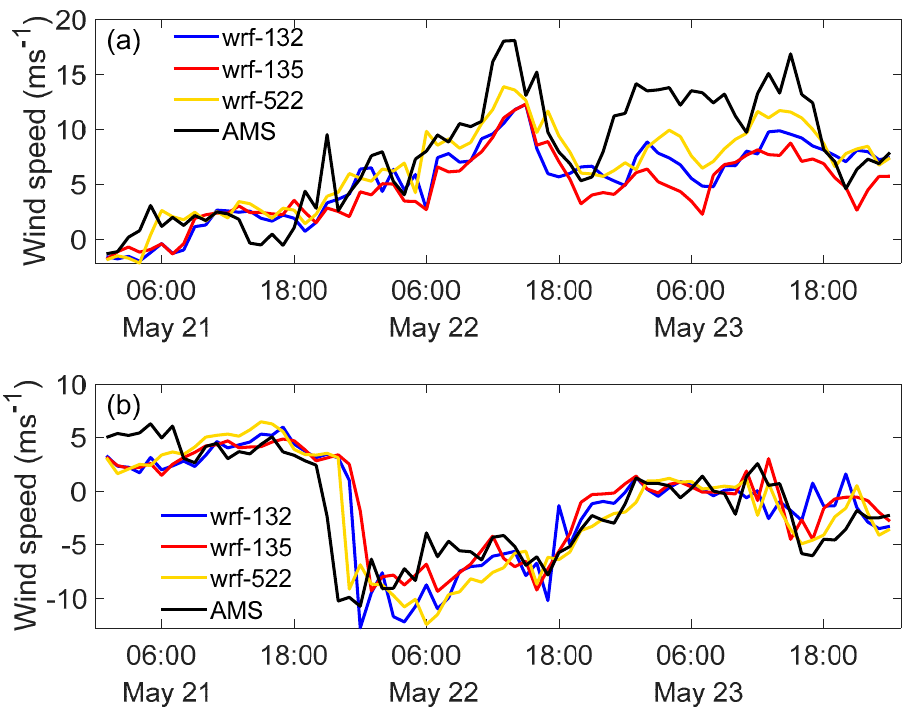
Figure 9. Time series of simulated wind speeds using different physical schemes for domain D4: ( a ) u component; ( b ) v component.